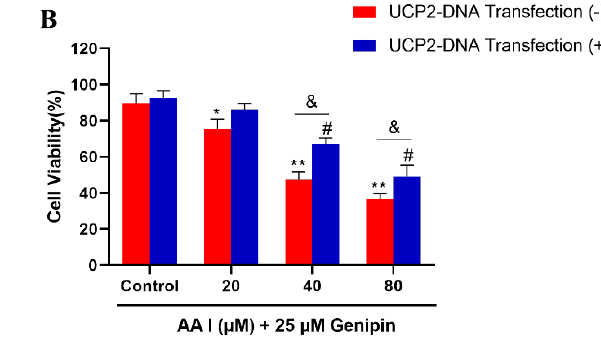
Figure 7. MTT was used for cell viability and cytotoxicity. ( A ) HK-2 cells with or without UCP 2-DNA transfection were treated with different concentration of AA I for 24 h. ( B ) HK-2 cells with or without UCP2-DNA transfection were treated with different concentration of AA I + genipin for 24 h. Each bar represents the mean ± SD of three independent experiments (* p < 0.05; ** p < 0.01; vs. UCP2-DNA Transfection ( − ) Control group; # p < 0.05 vs. UCP2-DNA Transfection (+) Control group; & p < 0.05). Table 2. IC 50 Values of AA I with or without genipin treating transfected or non-transfected cells. Parameter Values are given as the means ± SD, n = 3. * p < 0.05 vs. AA I transfection ( − ) group; # p < 0.05 vs. AA I with genipin transfection ( − )